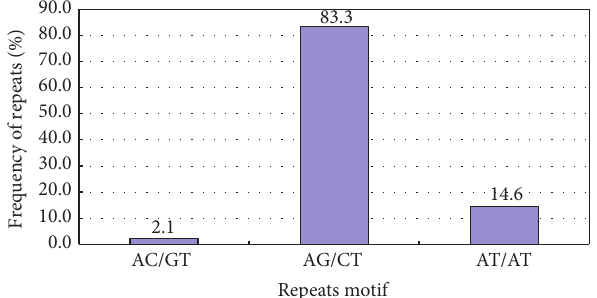
Figure 3: Dinucleotide repeats of Unigene.